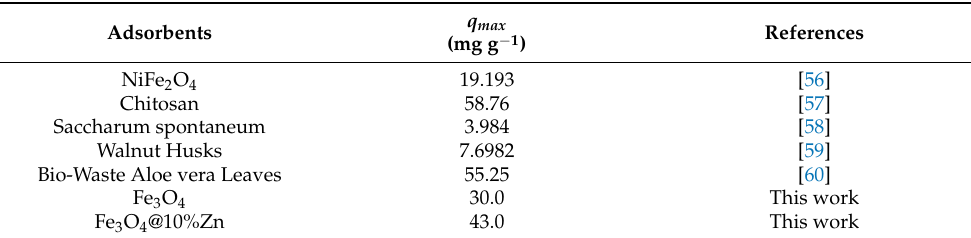
Table 5. Comparison of the maximum adsorption ( q max ) of different adsorbents for the removal of Titan